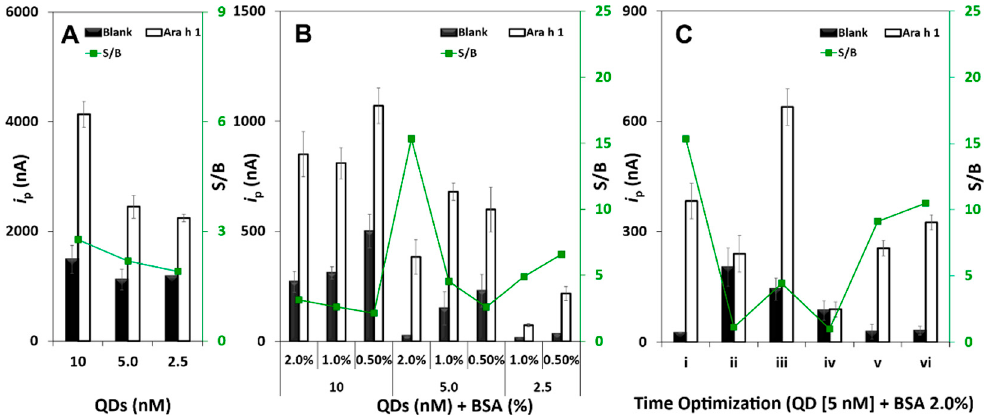
Figure 2. Results of the study/optimization in the absence (“B”, 0 ng · mL − 1 ) and in the presence (S, 250 ng · mL − 1 ) of Ara h 1 and the corresponding S/B ratio value for the following experimental parameters: ( A ) QDs concentration. ( B ) Addition of BSA to the tested QD solutions. ( C ) Assay format and time optimization using distinct assay strategies: i —step-by-step; ii —pre-incubation of DAb + QDs; iii —pre-incubation of target + DAb; iv —pre-incubation of target + DAb + QDs; v —pre- incubation of target + DAb; vi —(No blocker) pre-incubation of target + DAb (Experimental conditions: blocker (Tris BSA 2.0%), DAb (250× dilution in Tris BSA 1.0% (m/V), QDs (5.0 nM in Tris BSA 2.0% (m/V)).